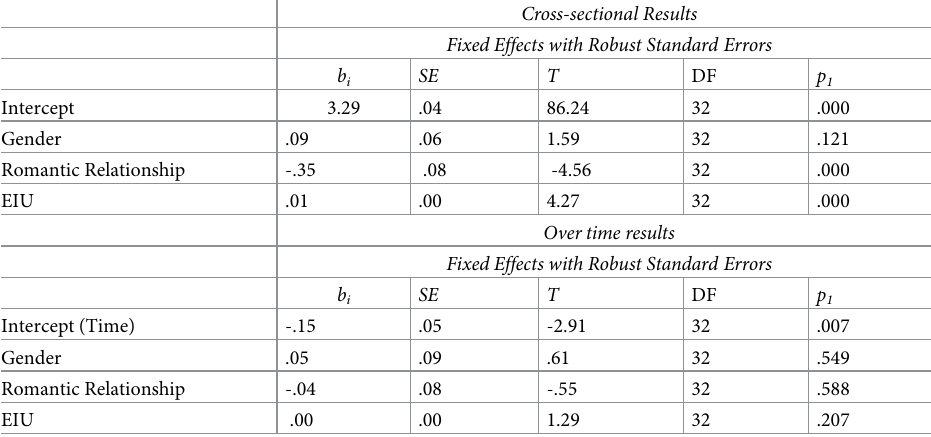
Table 4. HLM analysis predicting adolescents’ ARA